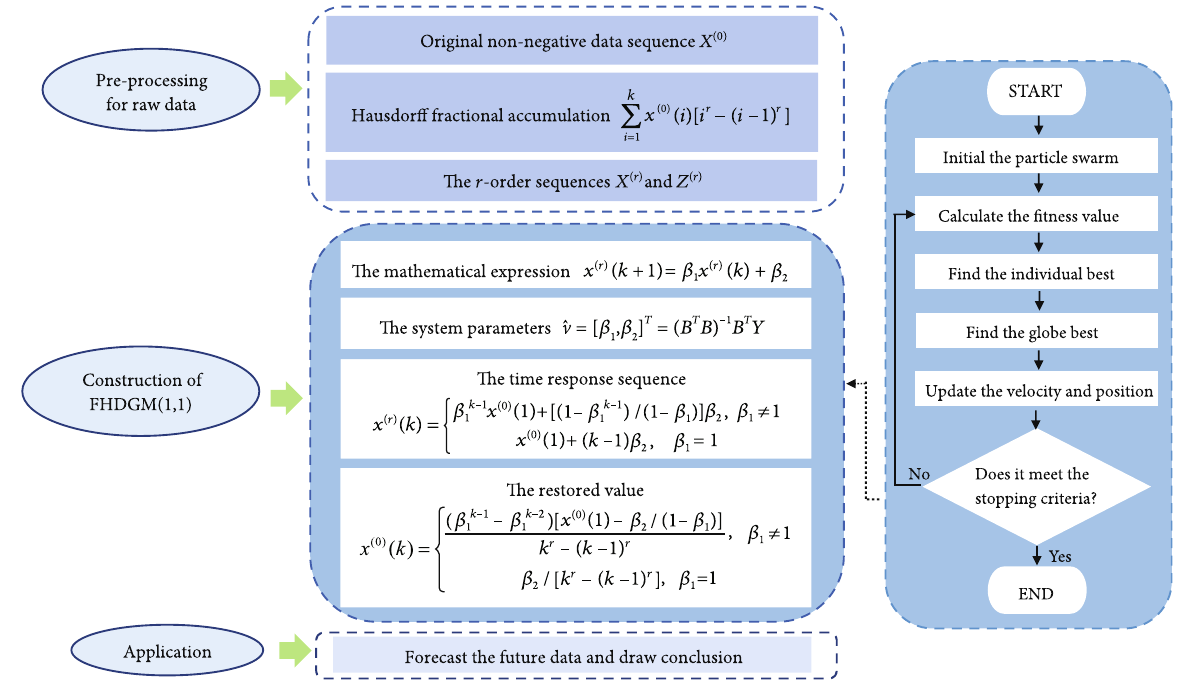
Figure 1: The fl owchart of the FHDGM (1,1) model. Table 1: Con fi guration of PSO in this